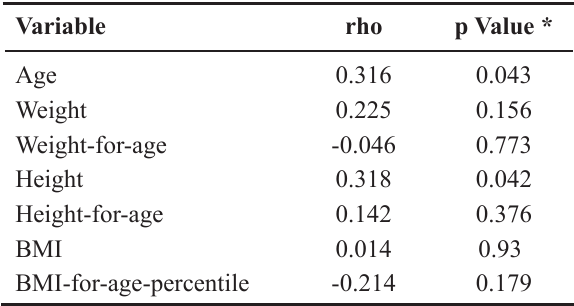
Table 1 – Results of statistical analysis in